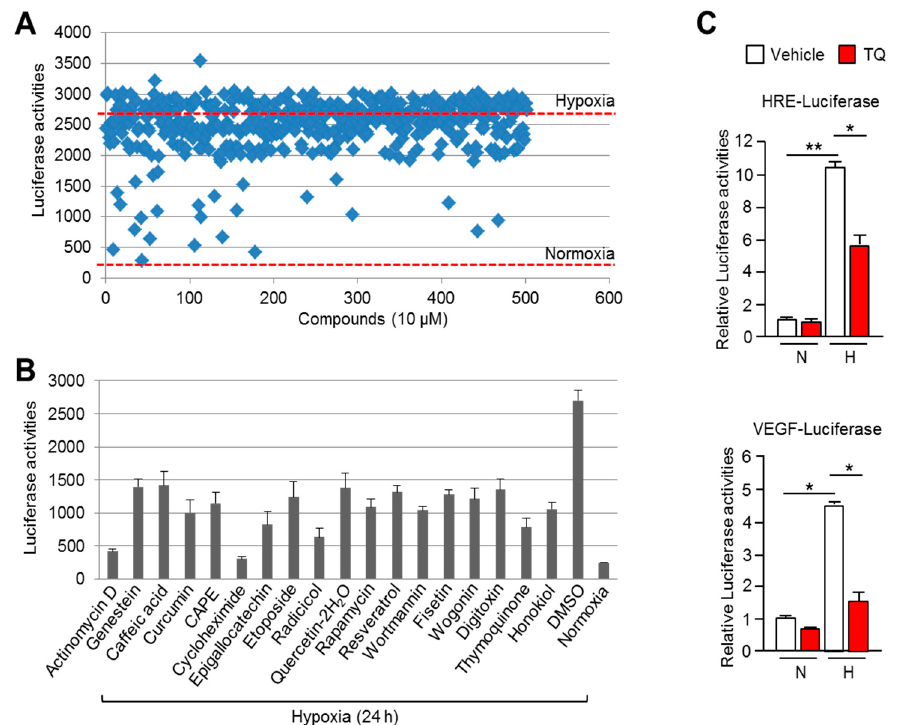
Figure 1. Luciferase assay-based large screening of natural compounds that inhibited Hypoxia-inducible factor-1 α (HIF-1 α ). ( A ) HEK293 cells, transiently expressing HRE-luciferase vector, were incubated with 502 natural compounds dissolved in dimethyl sulfoxide (DMSO). Each compound was used at final concentration of 10 µ M for 24 h under hypoxia. ( B ) HEK293 cells expressing HRE-luciferase vector were incubated with 10 µ M of 18 compounds for 24 h. The values represent the mean ± SD of three independent experiments performed. ( C ) HRE- and VEGF-luciferase vector was transiently transfected into Caki-1 cells, and then incubated for 24 h to allow stabilization. Cells were further incubated with 10 µ M of TQ for 24 h under normoxia or hypoxia. Luciferase activities were normalized using β -gal assay. The values represent the mean ± SD of three independent experiments performed in duplicate; * p < 0.05 and ** p < 0.01.